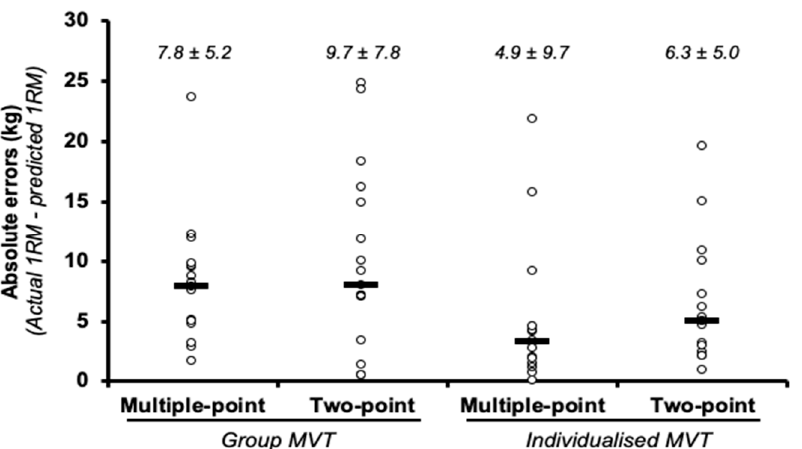
Data are mean ± standard deviation. Raw diff, Raw differences; ES, Cohen’s d effect size ([Predicted